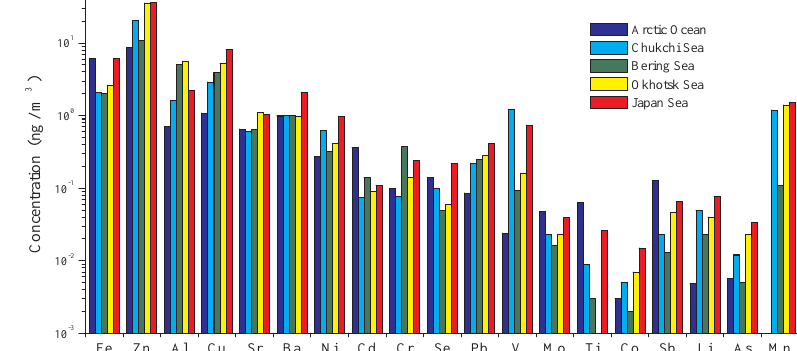
Figure 13. Average concentrations of elements in aerosol composition over Arctic and Far East seas.